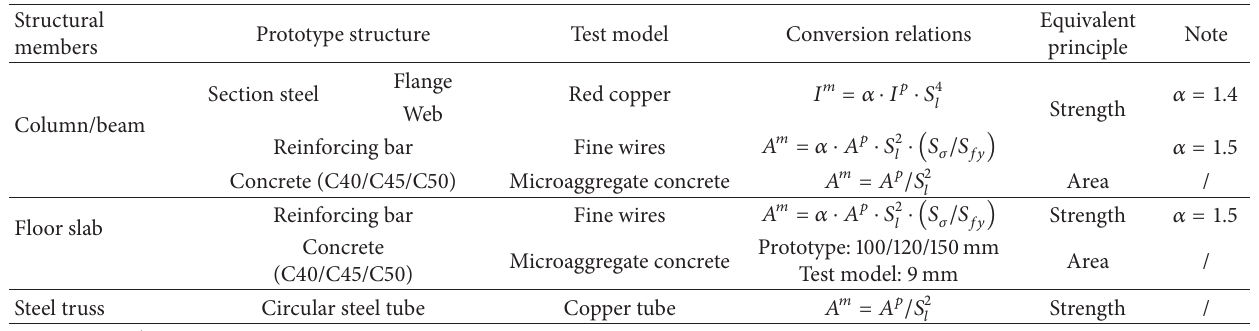
Table 4: Conversion principles of model materials.